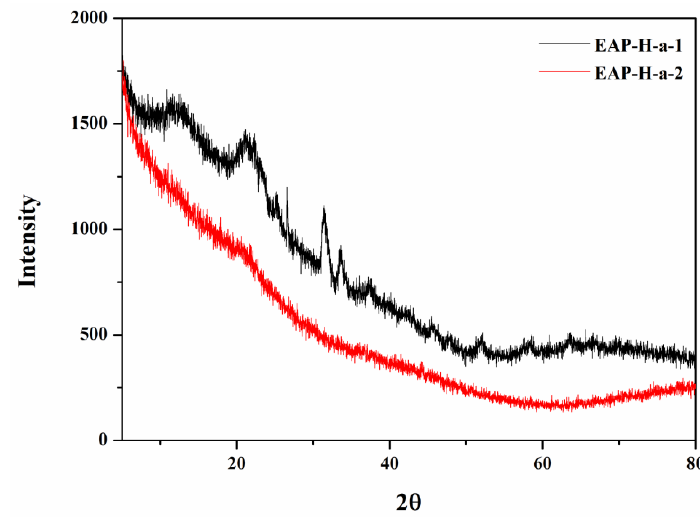
Figure 6. XRD spectrum of the EAP-H-a1 and EAP-H-a2.